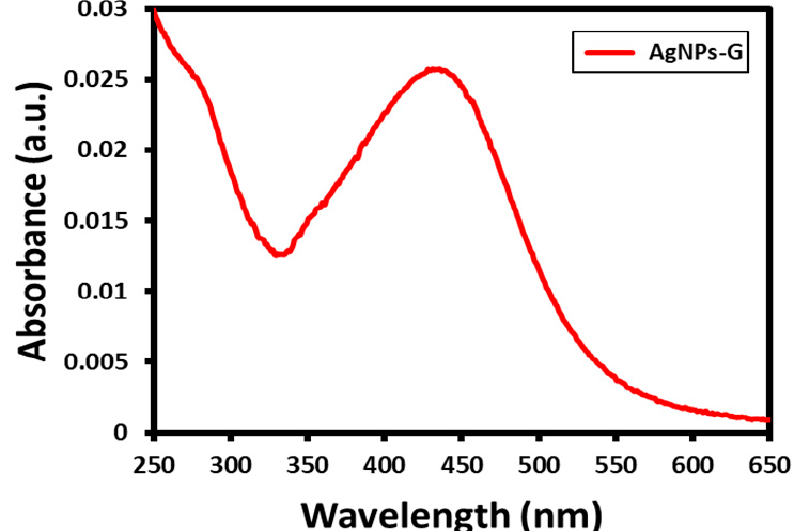
Figure 2. UV absorption spectroscopy analysis of the prepared AgNPs-G.